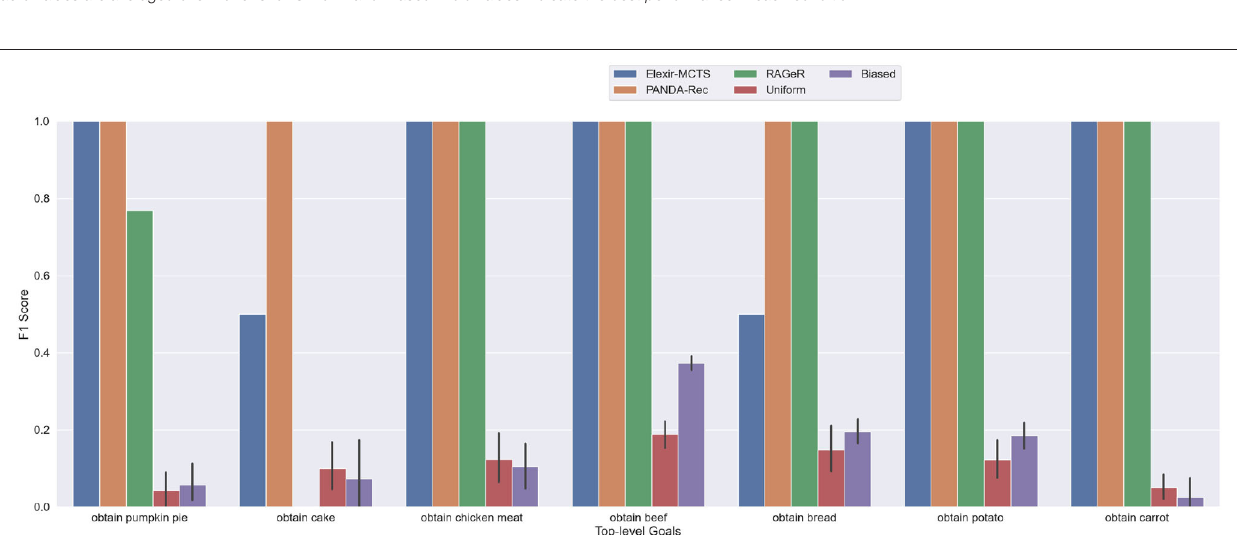
RAGeR on recognition of goals using the agent’s report of its executed actions. All results are reported in Table 3 . As